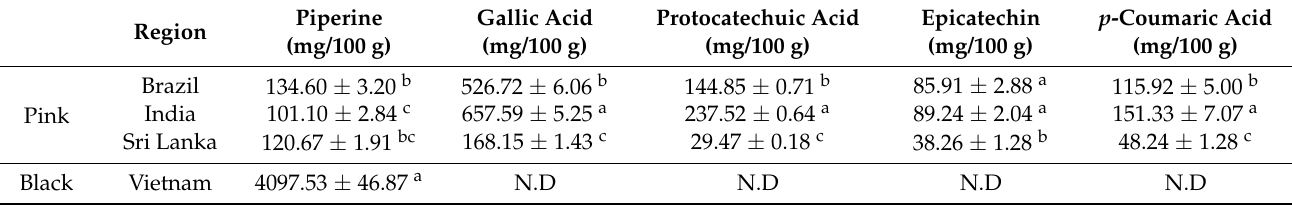
Table 4. Individual polyphenol profiles of pink and black